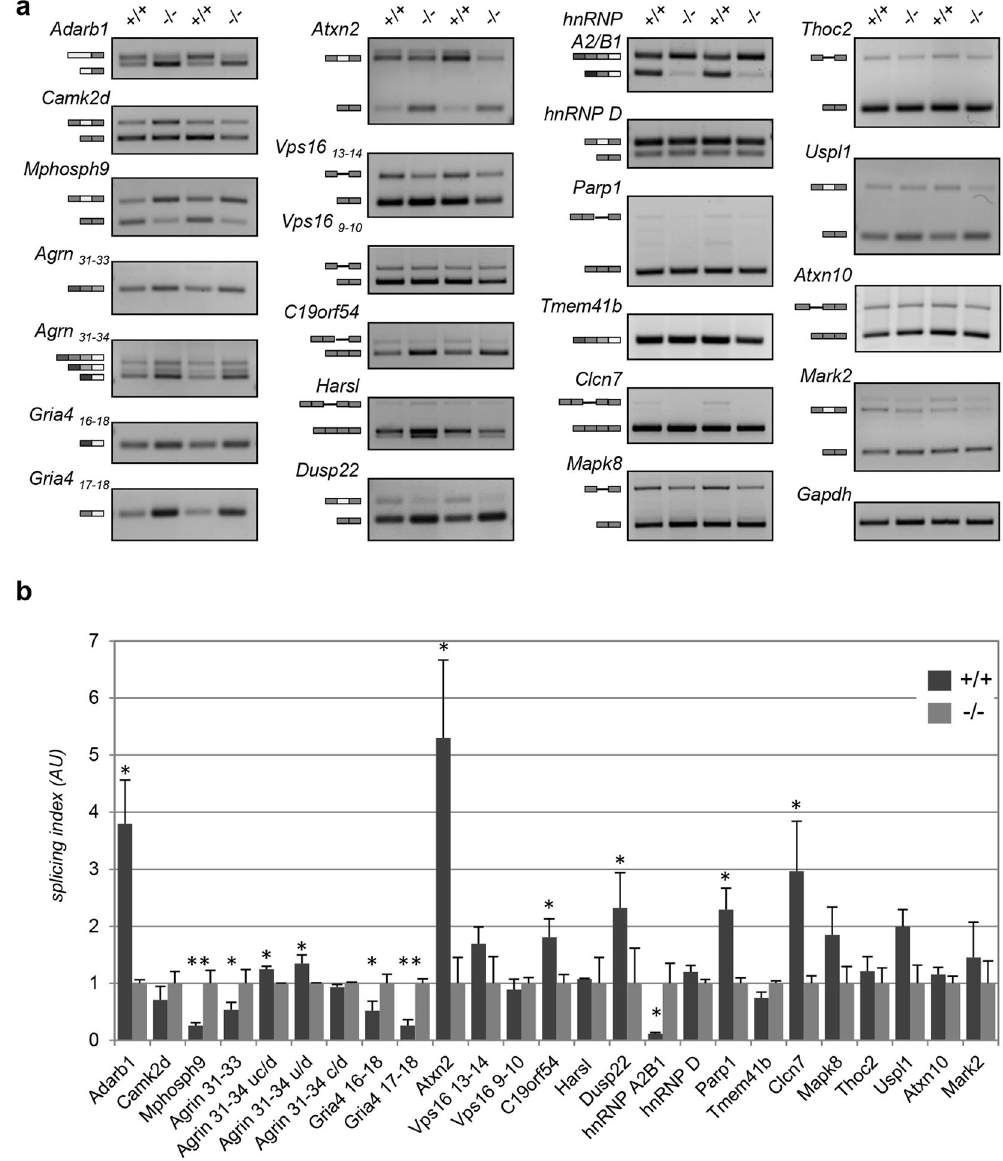
Figure 3. Alternative splicing of SMA target genes is altered in hFUS + / + mice. ( a ) Alternative splicing pattern of selected SMA target exons in hFUS + / + and hFUS − / − mice. Spinal cords from two different end stage FUS + / + mice were analysed, together with age-matched control animals. Results are representative of at least n = 3 independent experiments with 5 different mice. The exons analysed for each gene are reported in Supplemental Table 3. For Gria4, Vps16, and Agrin, different exons were examined, as indicated in subscripts. Schematics of exons (rectangles) and introns (lines) analysed are shown on the left. Full-length agarose gels are presented in Supplementary Figure 7. ( b ) Bands from the experiments exemplified in Fig. 3a were quantified by densitometry analysis, and a splicing index was calculated as follows: for genes that are expressed in more than one isoform, depending on the splicing event involved (i.e. exon skipping/intron retention), the ratios between the upper and the lower bands were calculated and scaled to have the average ratio in hFUS − / − mice at 1. For the Agrin gene (exon 31–34), the upper (u), central ( c ) and lower ( d ) bands correspond to isoforms containing exon 31/32/33/34, 31/33/34 and 31/34, respectively. The ratio between bands c/d, u/d and uc/d were calculated as indicated. For genes that are expressed as a unique isoform, the splicing index was calculated as the ratio between band intensity and the relative intensity of the housekeeping Gapdh mRNA. Results from n = 5 independent mice have been considered for each genotype. Mean ± SD is shown. One asterisk is shown when p ≤ 0.05, two asterisks when p ≤